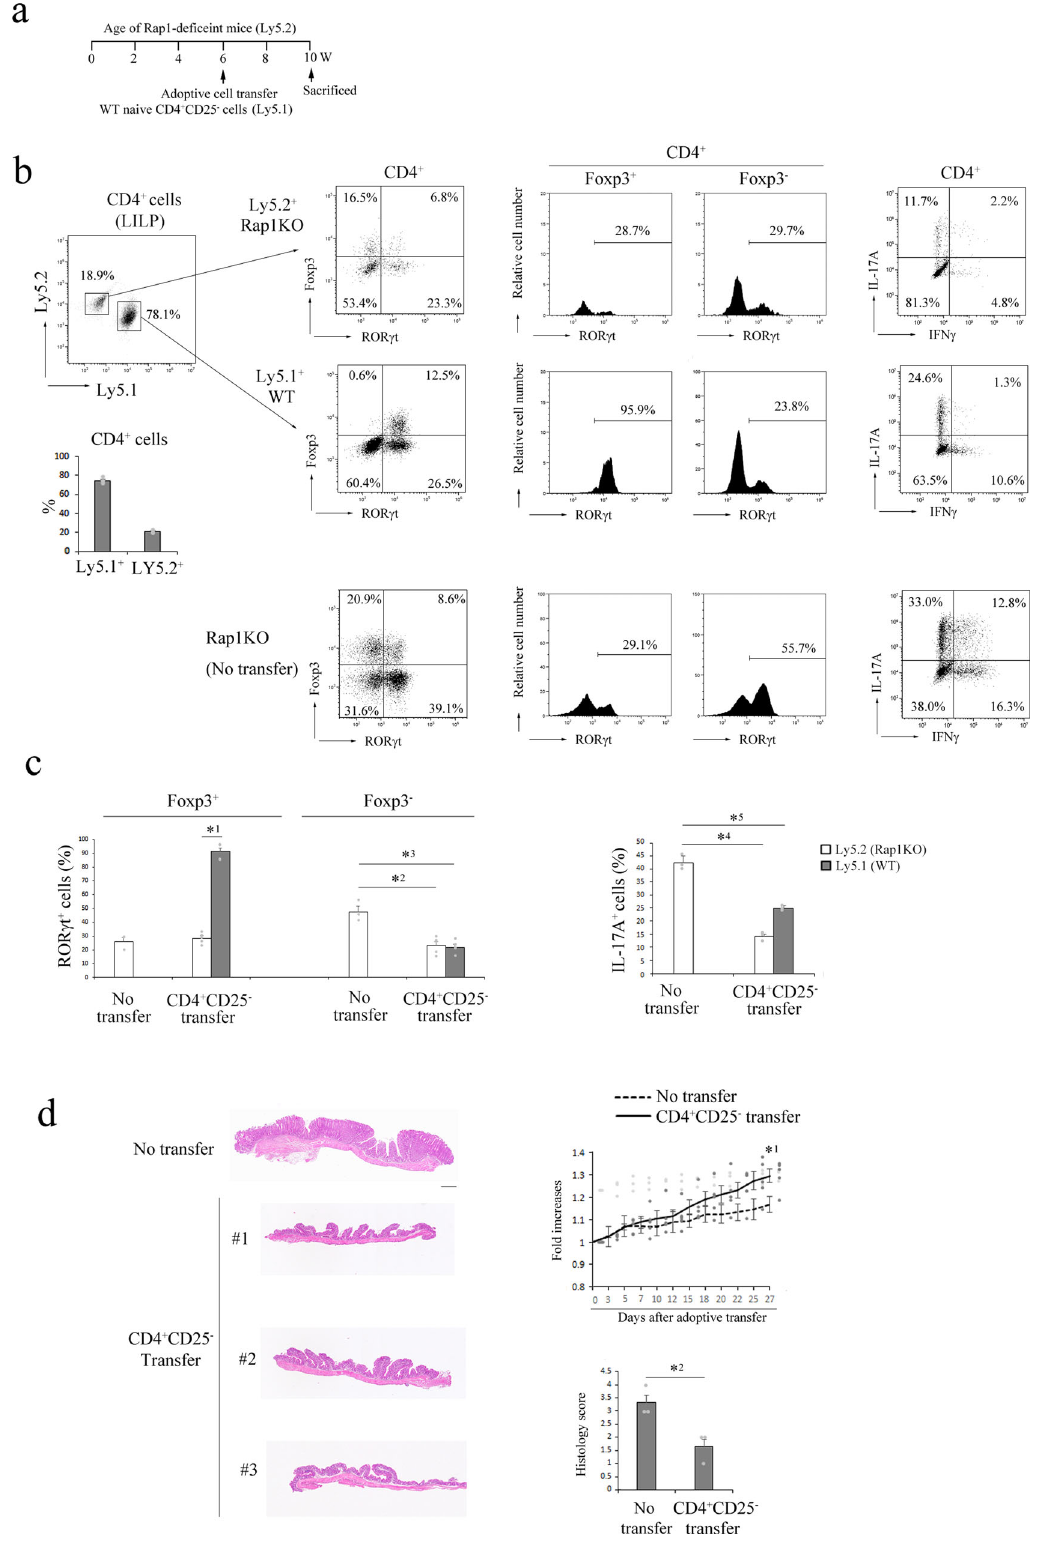
transcription factor and cytokines. As shown in Fig. 5a, ROR γ t expression in Rap1-de fi cient naïve CD4 + cells under Th17- polarizing conditions was comparable to that in WT naïve CD4 + cells, while IL-17 production in Rap1-de fi cient naïve CD4 + cells was lesser than that in WT naïve CD4 + cells in the presence of